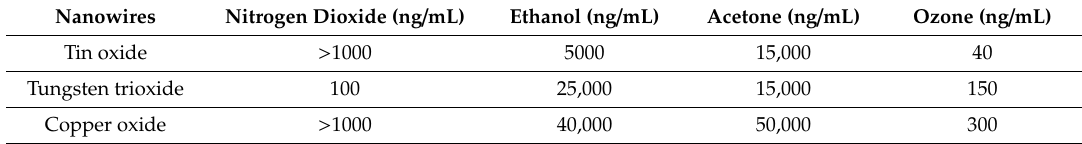
Table 5. Detection limits of the three types of nanowires for the four tested compounds [120] . Nanowires